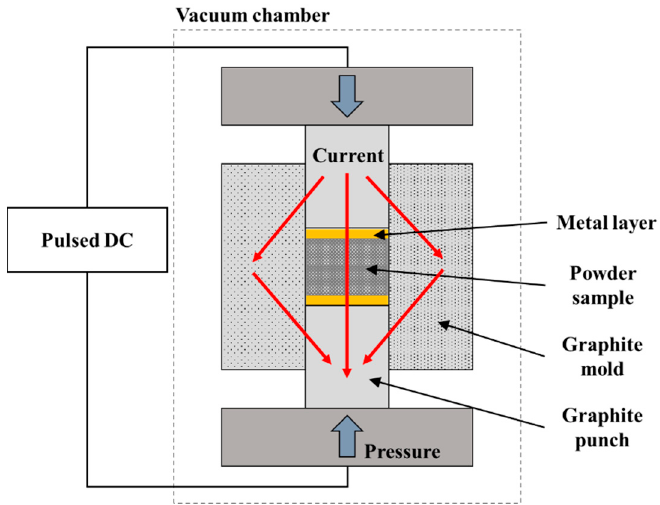
Figure 1. Schematic of co-sintering process of thermoelectric material and metal layer using SPS (Spark Plasma Sintering).